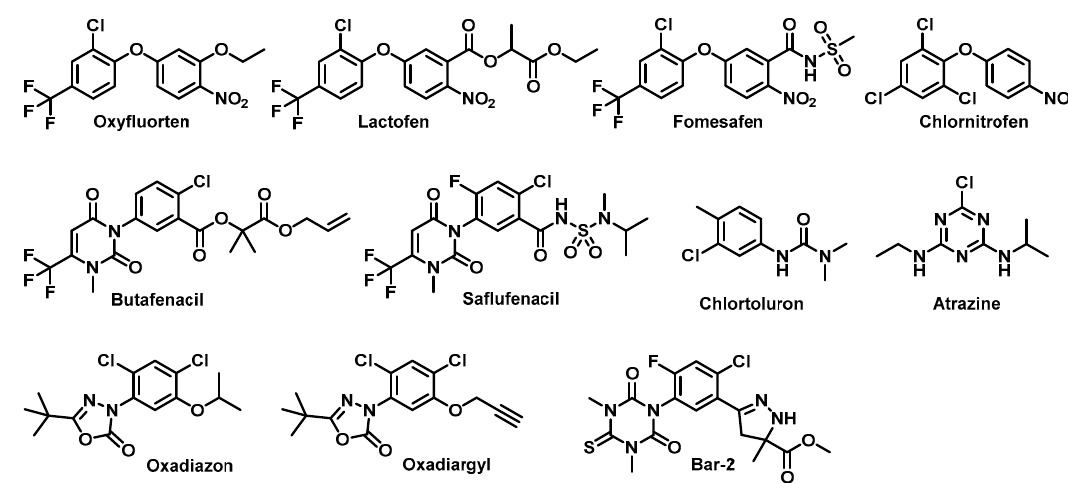
Figure 3. Structures of the tested commercial herbicides and Bar-2.